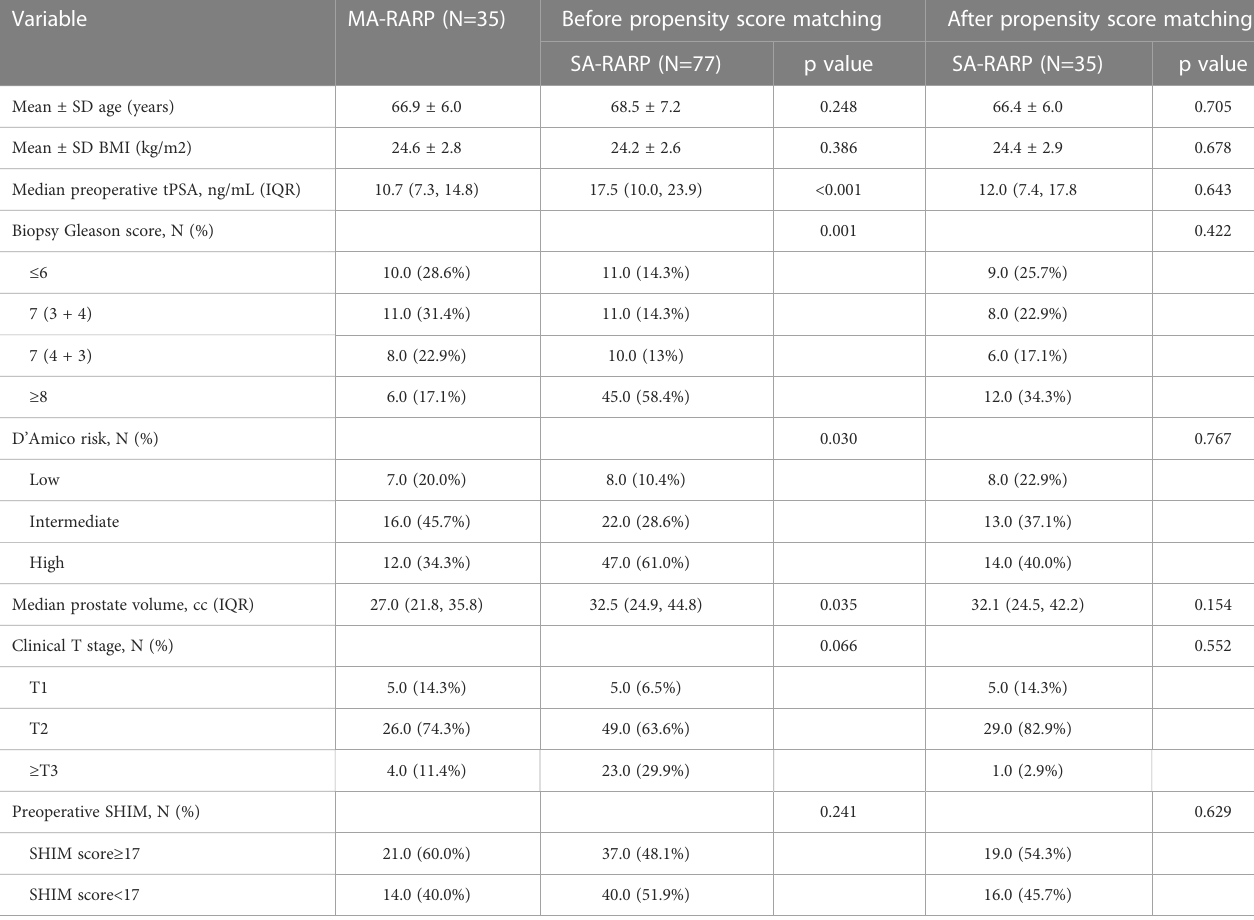
TABLE 1 Post-matching baseline characteristics of 35 patients who underwent SA-RARP and 35 patients who underwent MA-RARP.